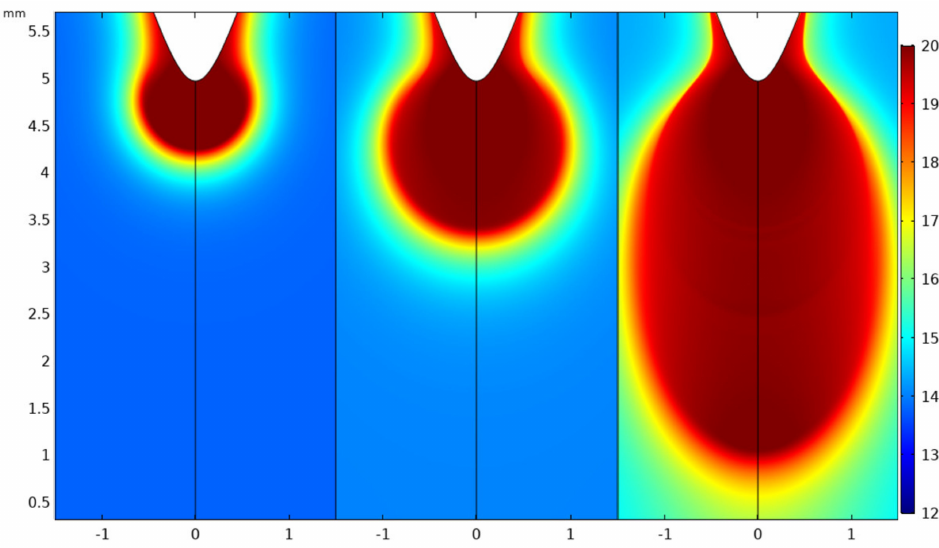
Figure 5. 2D surface plot of electron density profile at times 0.5, 1, and 2 ns in air at atmospheric pressure. Gap distance 5 mm, S b = 10 23 m − 3 s − 1 . Scaling parameter: 20 on logarithmic plot represents a density value of 10 20 m − 3